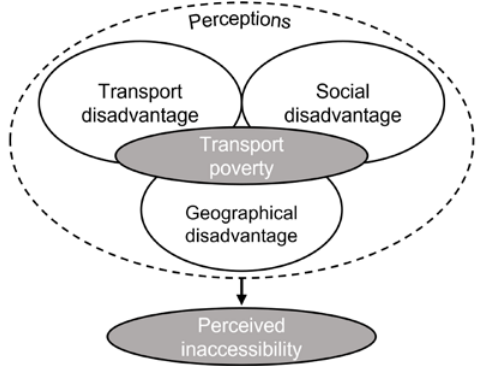
Figure 1. Analytical framework of transport